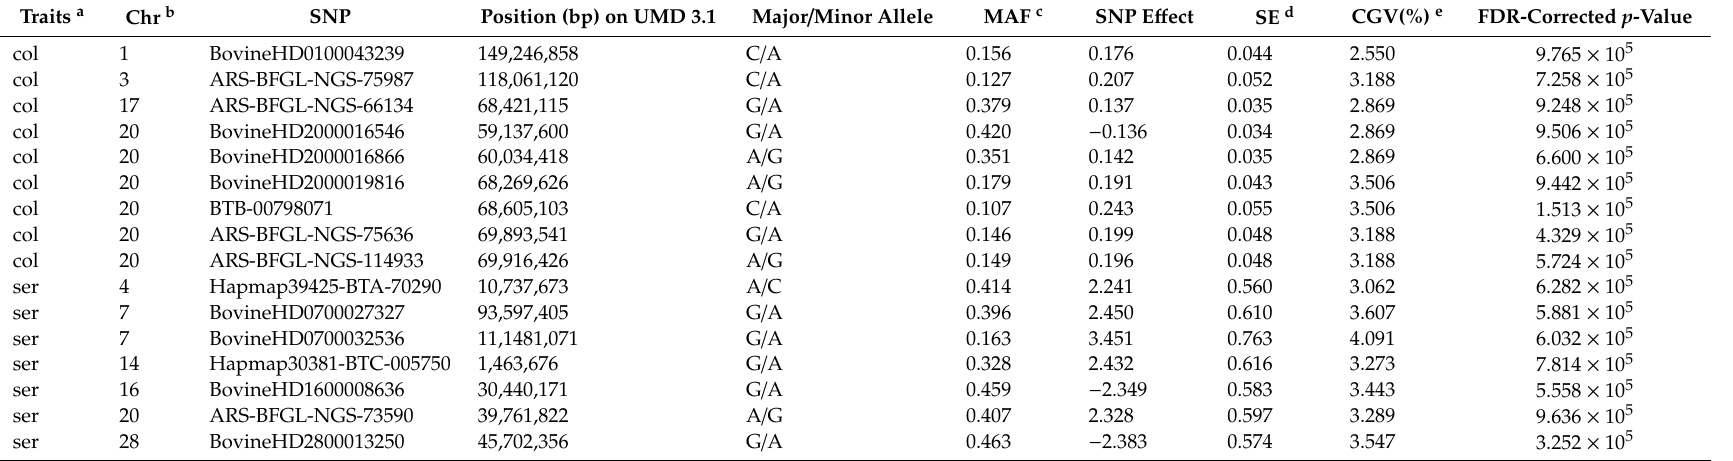
Table 2. The significant SNPs of the genome-wide association studies for the concentration of albumin in colostrum and